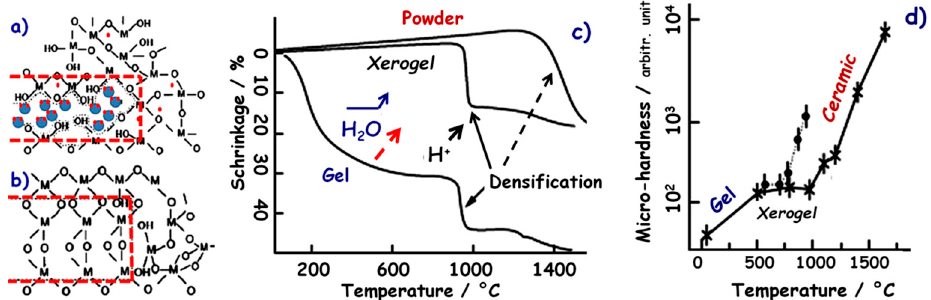
Figure 3. Schema of the transformation of a (micro / meso)porous xerogel ( a ) into a dense oxide ( b ); ( c ) comparison of the shrinkage of a gel, a xerogel and corresponding oxide powder; ( d ) evolution of the R.T. microhardness (logarithmic scale) with thermal treatment (dashed line: Na superionic conductor (NASICON); solid line: mullite; after [2]).